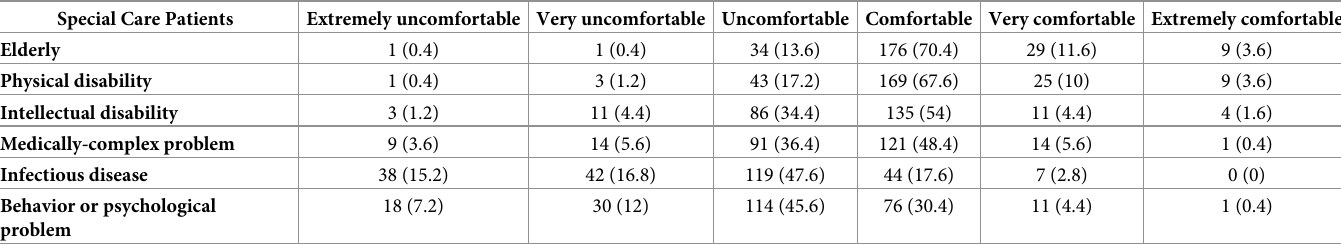
Table 4. Distribution of respondents’ perception of comfort towards special care patients (N,